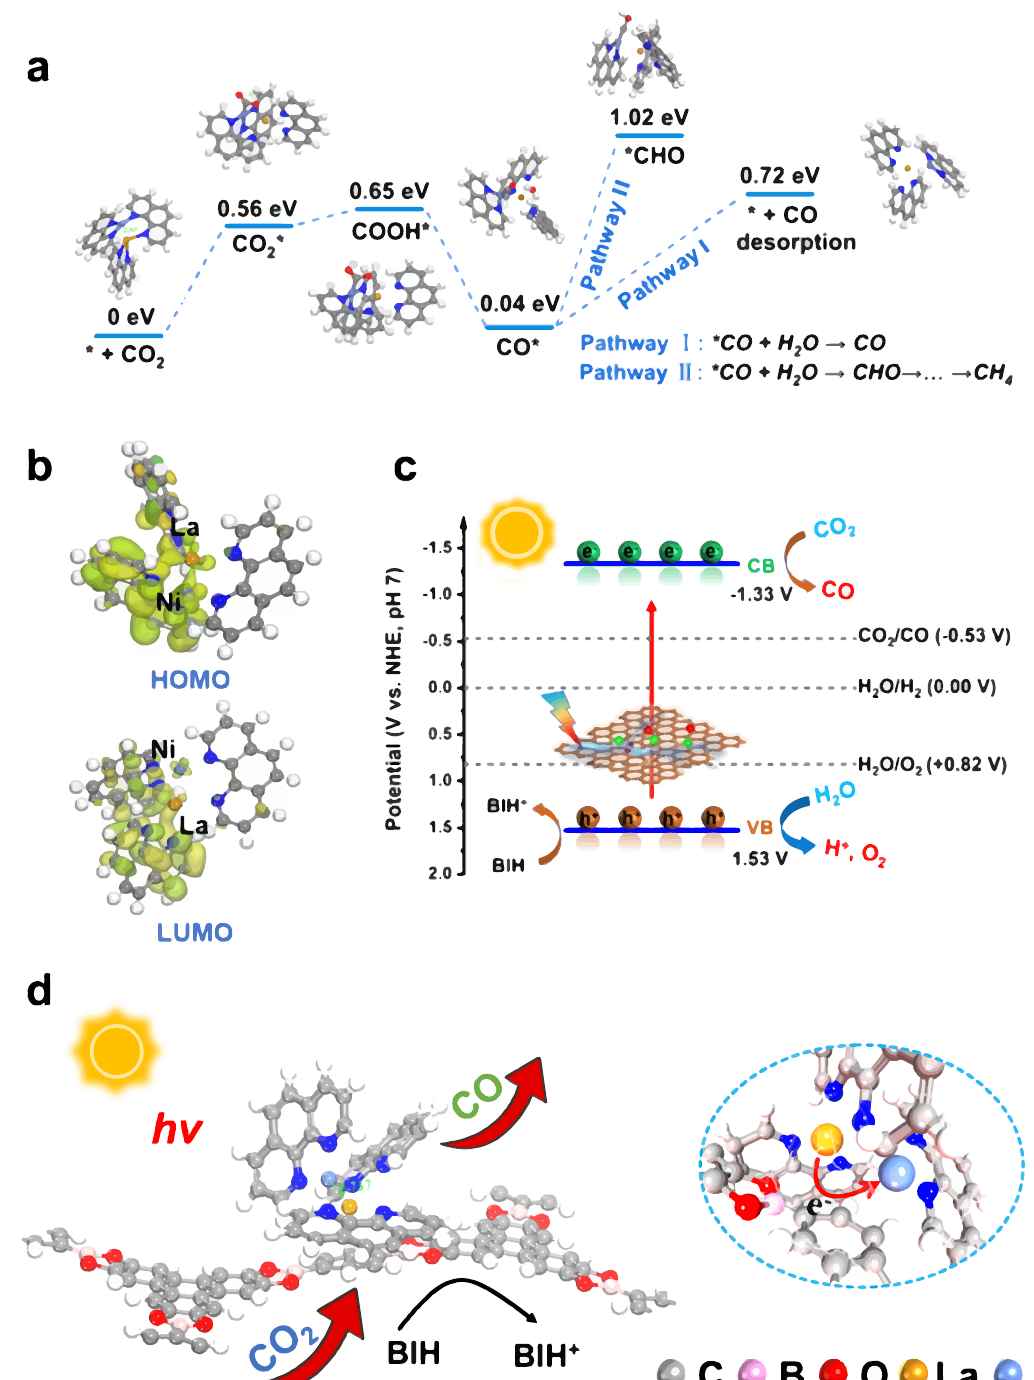
Fig. 6 | Analysis of the reaction mechanism for the photoreduction of CO 2 to CO. a Reaction pathways for CO 2 photoreduction on LaNi-Phen/COF-5 with cor- responding geometry structures. b HOMO-LUMO charge-transfer transitions for